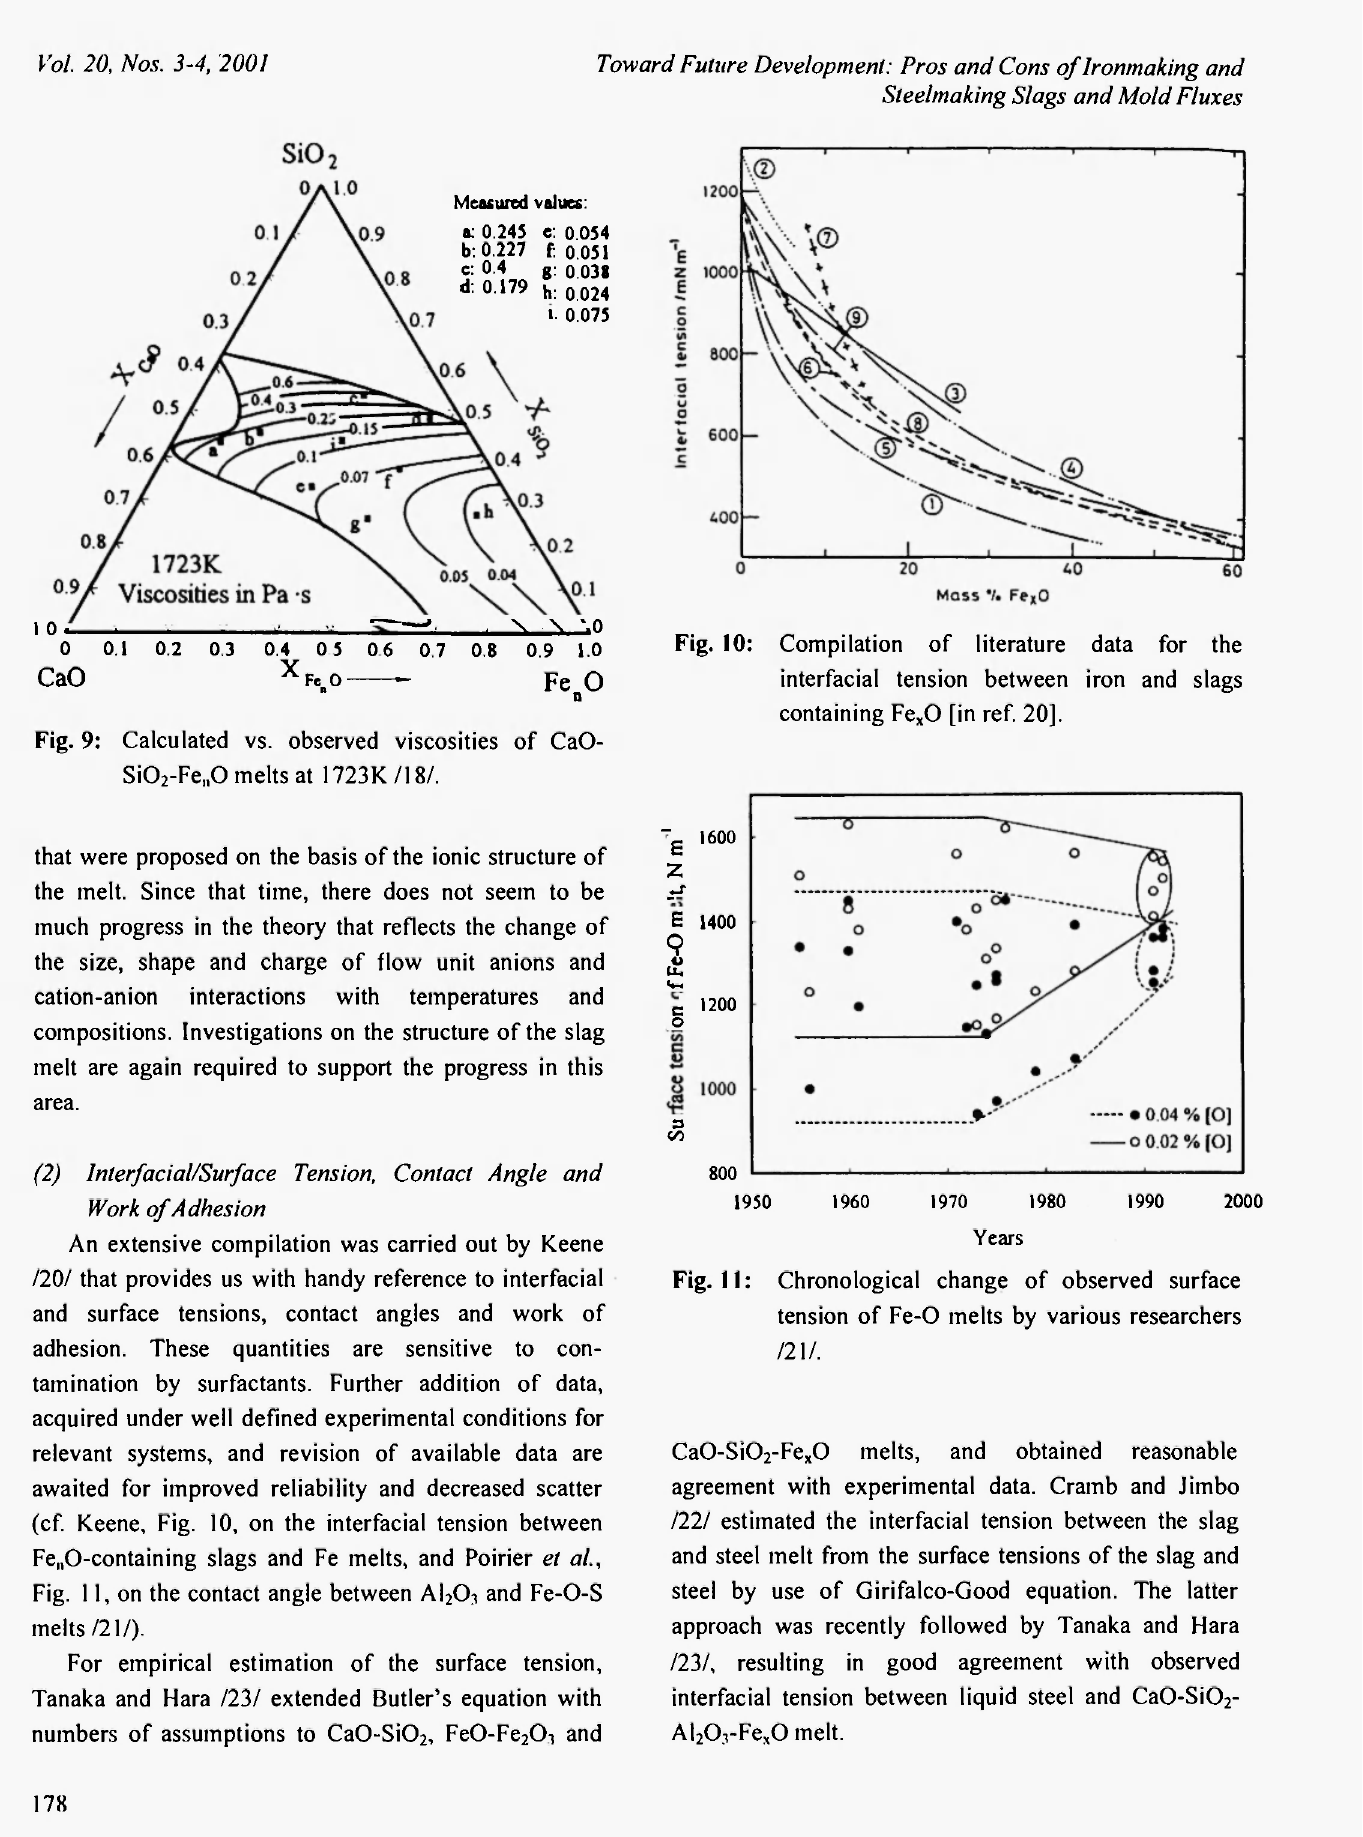
Fig. 11: Chronological change of observed surface tension of Fe-0 melts by various researchers /21/.